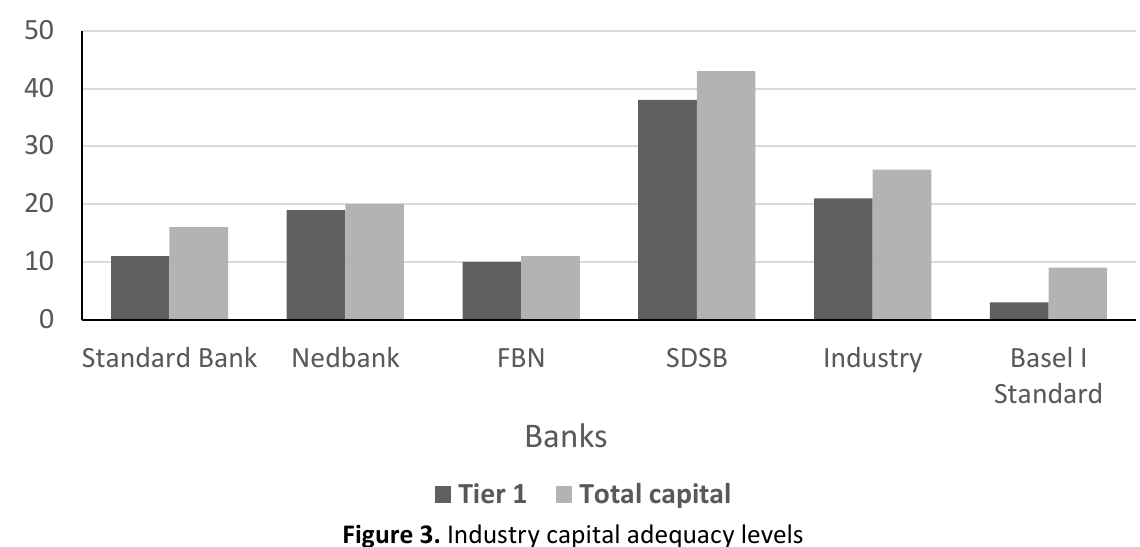
Figure 3. Industry capital adequacy